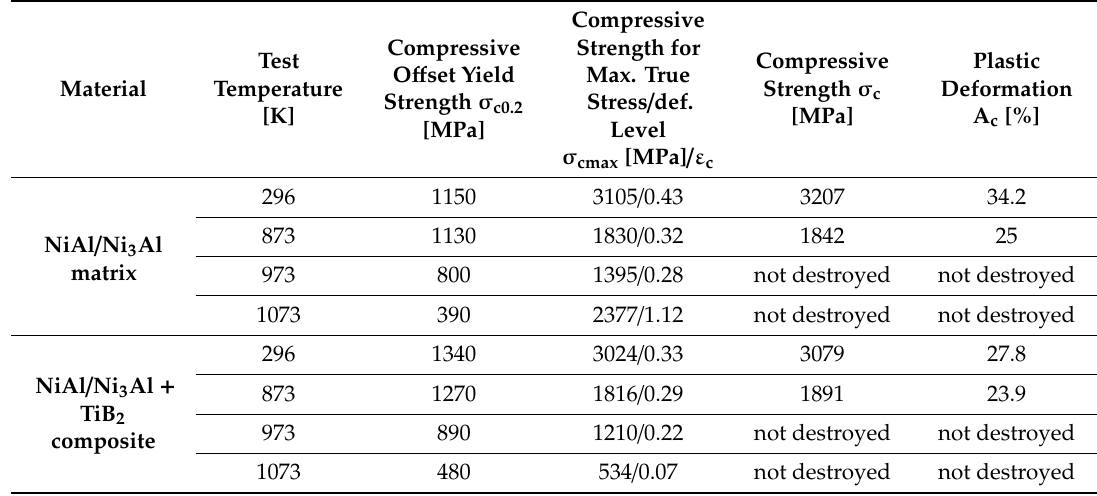
Figure 8. ( a ) Compressive stress–strain curves of the dual-phase NiAl/Ni 3 Al matrix and the NiAl/Ni 3 Al + TiB 2 composite, specimens with dimensions h × d (scheme) were deformed at room temperature at the initial strain rate, ( b ) brittle–ductile fracture in the NiAl matrix sample (after destruction), and ( c ) microstructure observed on the flat side surface of the NiAl + TiB 2 composite sample (before destruction) after the compression test; the direction of compression as indicated in the sample scheme. Table 2. Strength properties of the tested materials obtained in a compression test carried out at room temperature and at elevated